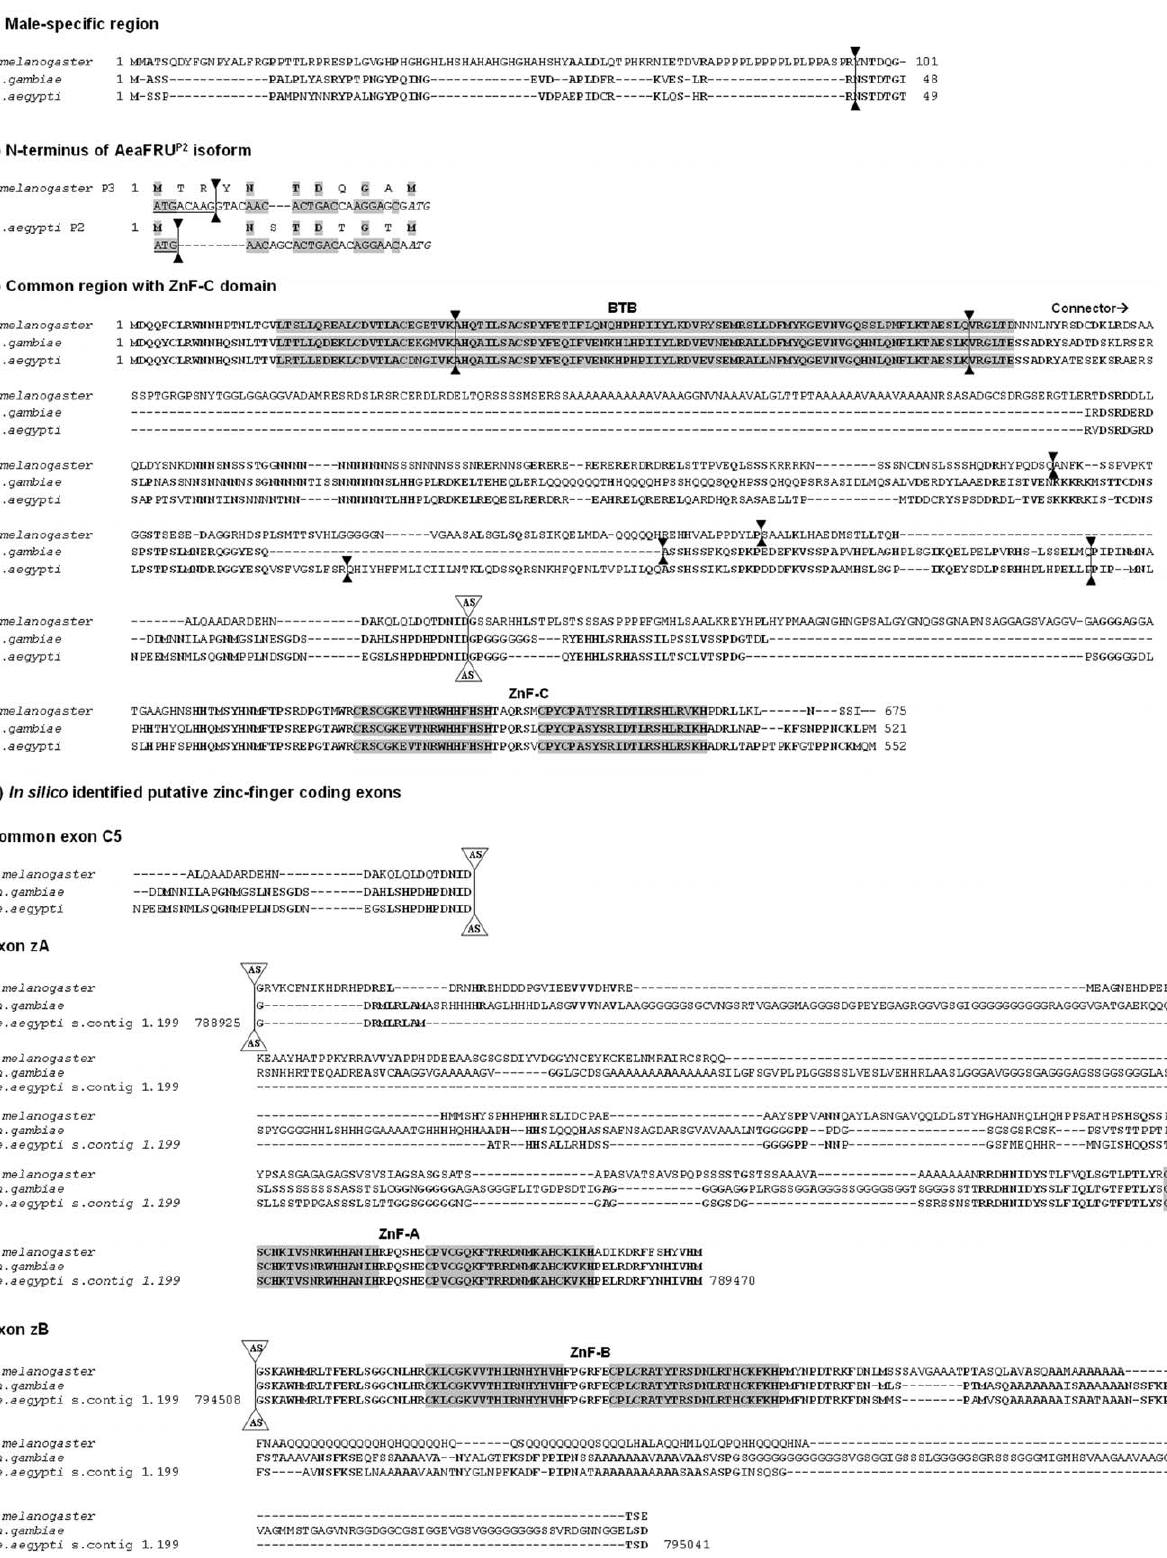
Figure 2. Multiples sequence alignment of the FRU isoforms. Protein sequence alignment of the fru isoforms of D. melanogaster , An. gambiae and Ae. aegypti . The conserved BTB domain and zinc finger domains are boxed in grey. Bold letters indicate amino acid identity among Drosophila , Anopheles and Aedes or between two of them. Intron positions are indicated by solid triangles and position of 3 9 alternative splicing site is indicated by AS triangles. Gaps were introduced in the alignments to maximize similarity. The sequences are divided into: (A) a male-specific N-terminal portion